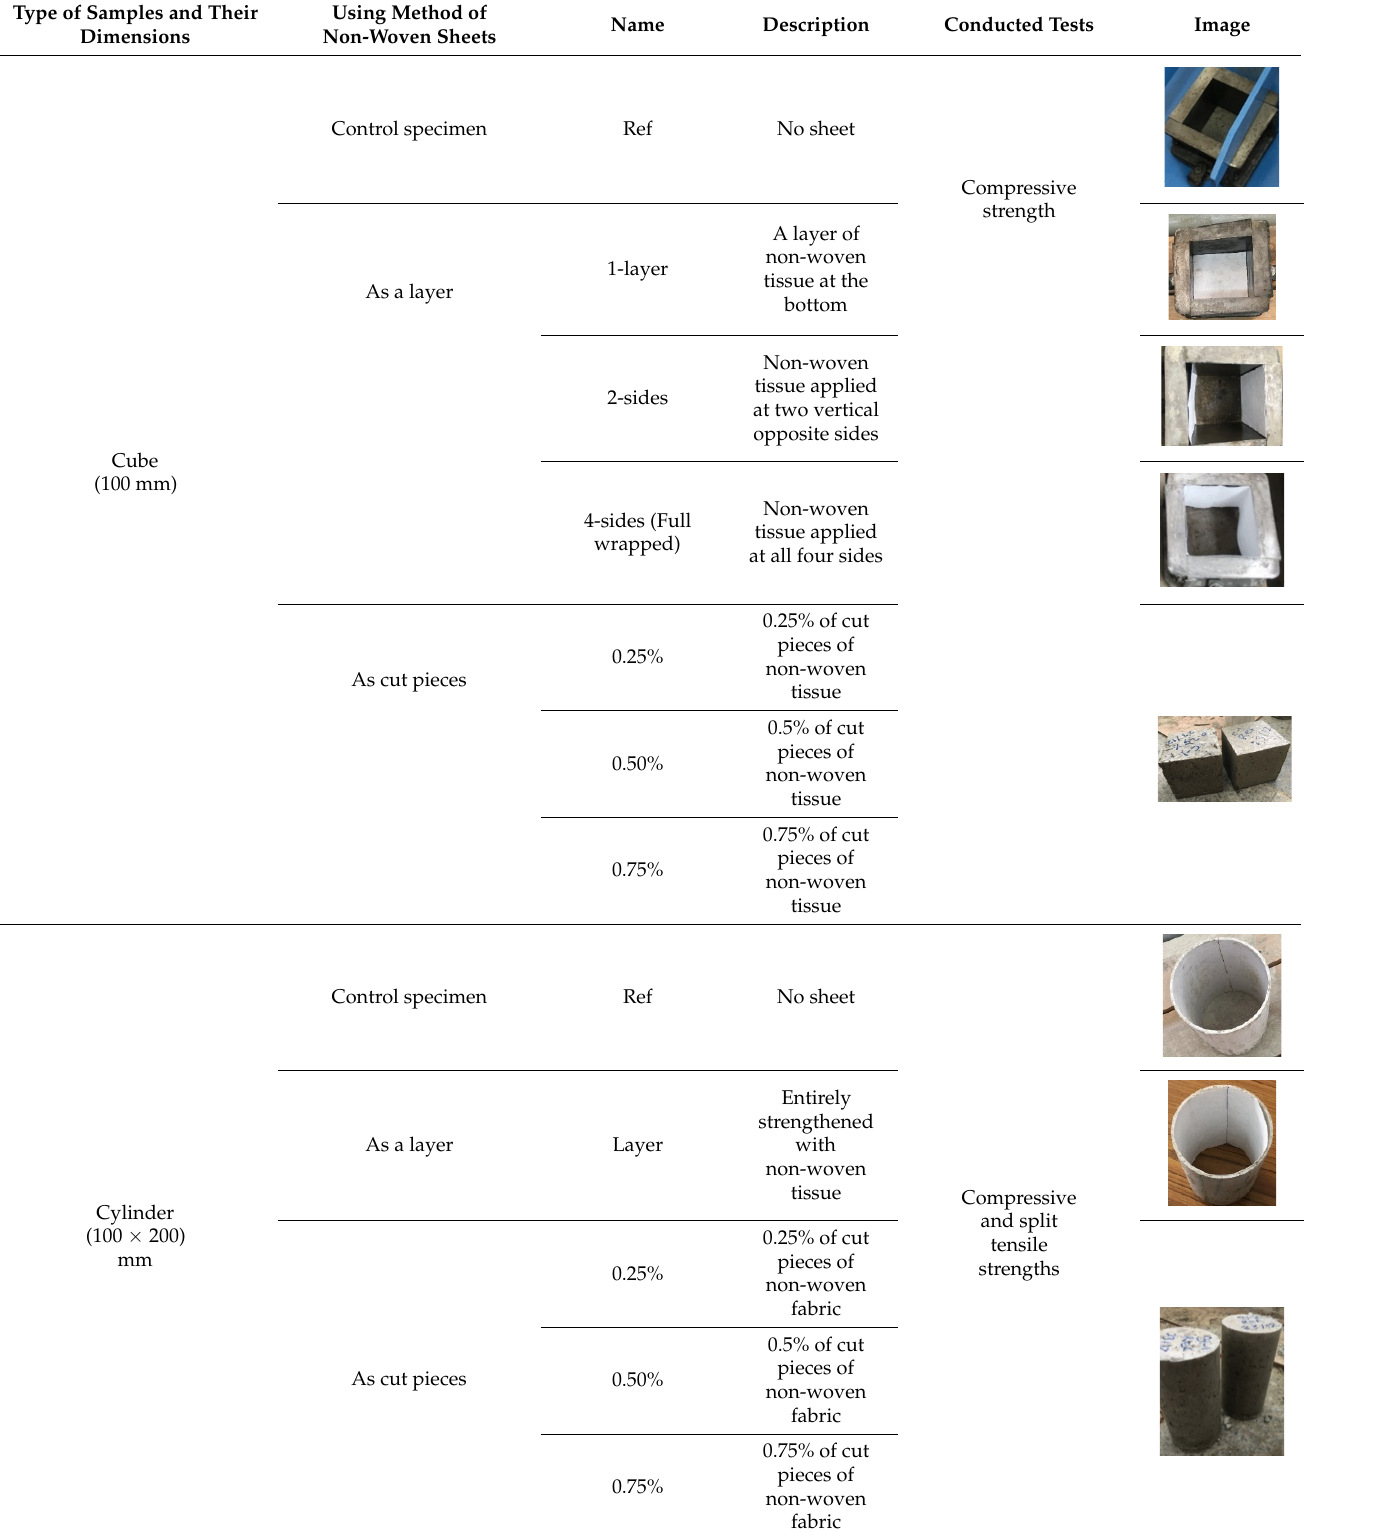
Table 5. Type of samples and exposed tests.